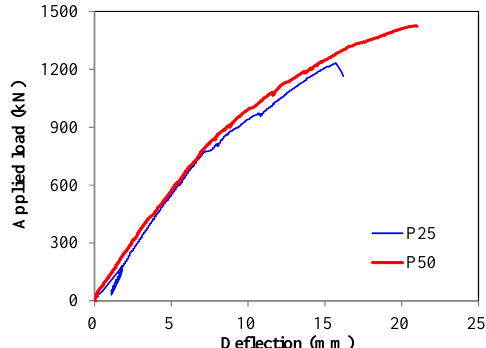
Figure 12. Load-center deflection response.